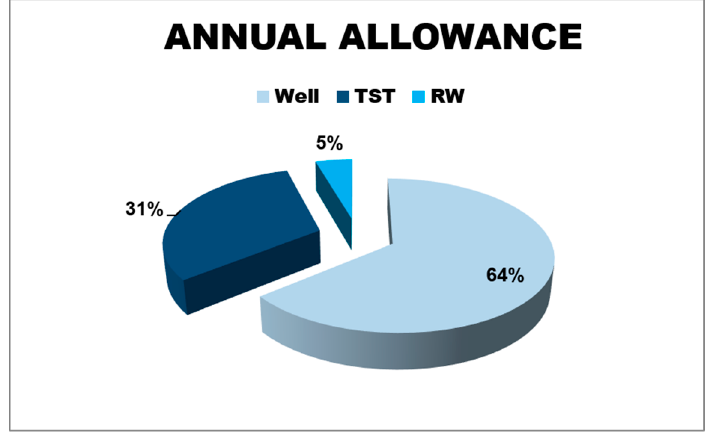
Figure 2. Percentage of water volume needed to cover the demand, according to the water supply source.